Question: Looking at the figure, what chart type is it?
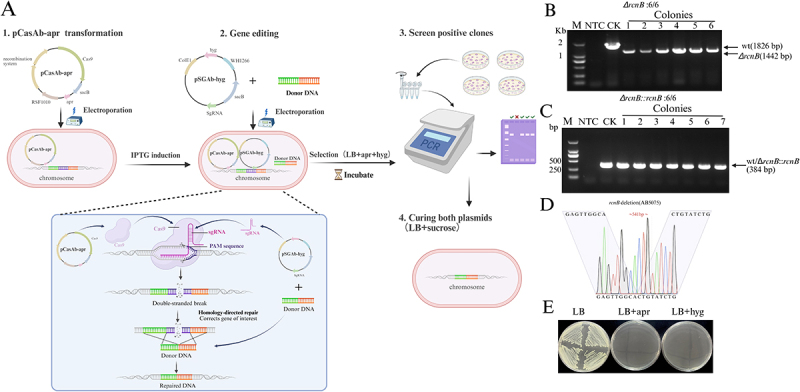
Answer: scatter